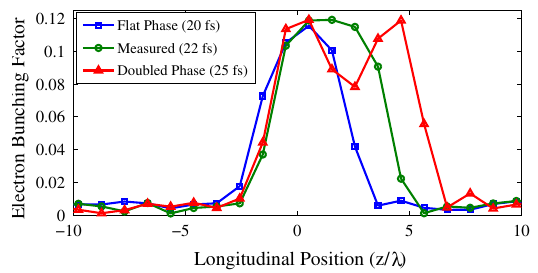
FIG. 12. Slice electron bunching vs time for parameters of Table I. Bunching is shown for the 30th harmonic of laser pulses simulated with flat phase (blue squares), measured phase (green circles), and twice the measured phase (red triangles).